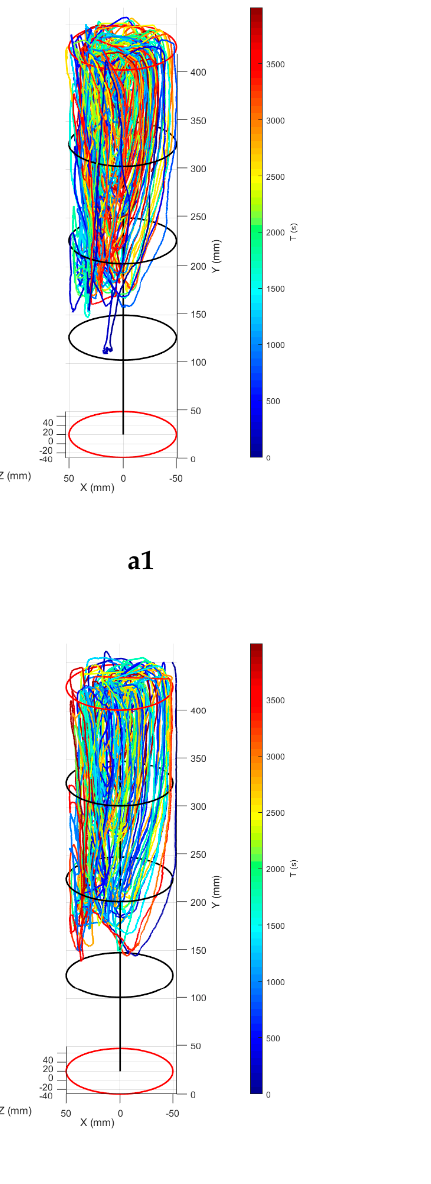
Figures 7 and 8 show the results of the two runs (a and b) for the − 150 + 106 µ m hematite particle with an airflow rate of 1.25 u mf and 1.50 u mf ,